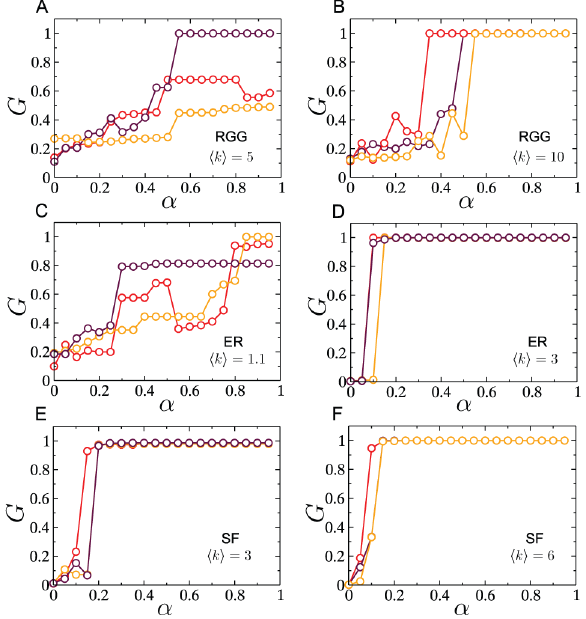
Figure 4. Cascades on single network realizations. Simulations were performed on networks of size N ~ 1300 . Fractional size of surviving giant component as a function of a for (A),(B) RGGs, (C),(D) ER networks and (E),(F) SF